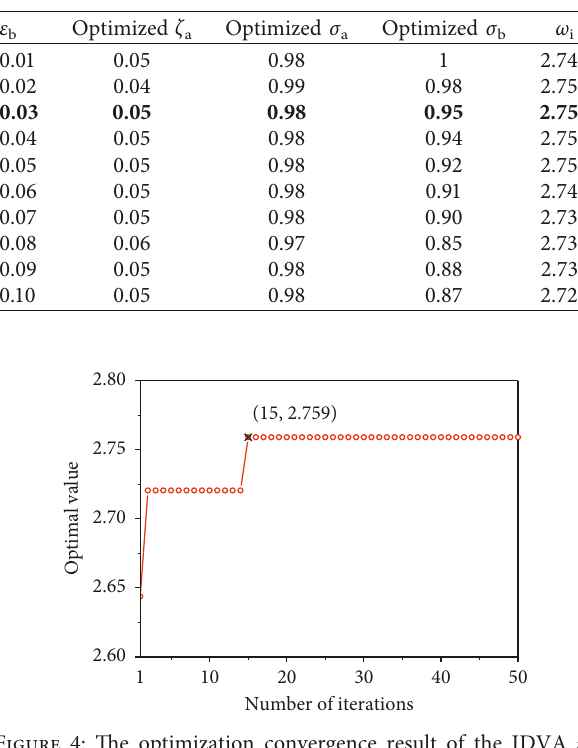
Figure 3: The flow chart of the QPSO algorithm. Table 1: The parameters optimization results of the IDVA